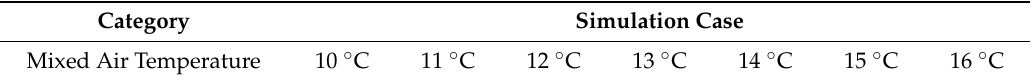
12 of 19 Figure 7. Relationship between the indoor load and predicted load.